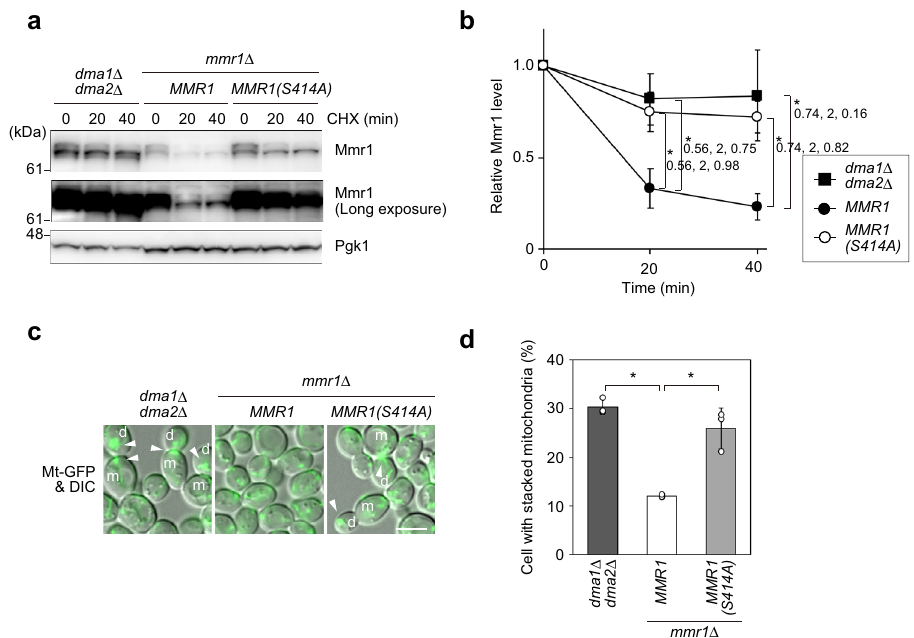
Fig. 6 Ser414 residue in Mmr1 is important for its rapid turnover. a YTK5416 ( dma1 Δ dma2 Δ ), YTK5675 ( mmr1 Δ MMR1 ), and YTK5764 [ mmr1 Δ MMR1(S414A) ] cells were grown to log phase in YPD medium, treated with CHX, and harvested. Their total lysates were subjected to immunoblot analysis with anti-Mmr1 or, to demonstrate uniform loading, anti-Pgk1 antibody. b Mmr1 level was measured, normalized with that of Pgk1, and shown as a relative value to that at 0 min. c YTK5341 ( Mt-GFP dma1 Δ dma2 Δ ), YOK5455 ( Mt-GFP mmr1 Δ MMR1 ), and YOK5456 [ Mt-GFP mmr1 Δ MMR1(S414A) ] cells were grown to log phase in synthetic complete medium and observed under a fl uorescence microscope. m and d, mother cell and daughter cell, respectively. Arrowhead, stacked mitochondria. Bar, 5 µ m. d Proportion of cells with stacked mitochondria was calculated. Values in ( b ) and ( d) represent the mean ± SD from three independent experiments. Signi fi cance was tested by one-way analysis of variance with Dunnett ’ s comparison (values of con fi dence intervals, degrees of freedom, and F are indicated) ( b) or Steel ’ s comparison test ( d ). * P <